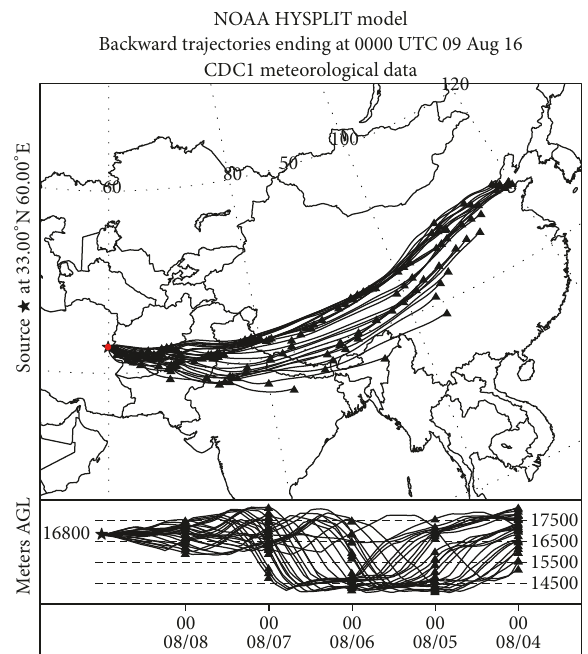
Figure 10: The ensemble backward trajectories at 16.8 km on Aug 9, 2016. The trajectory released at 33 ∘ N, 60 ∘ E (red dot). The duration is 120 hours.